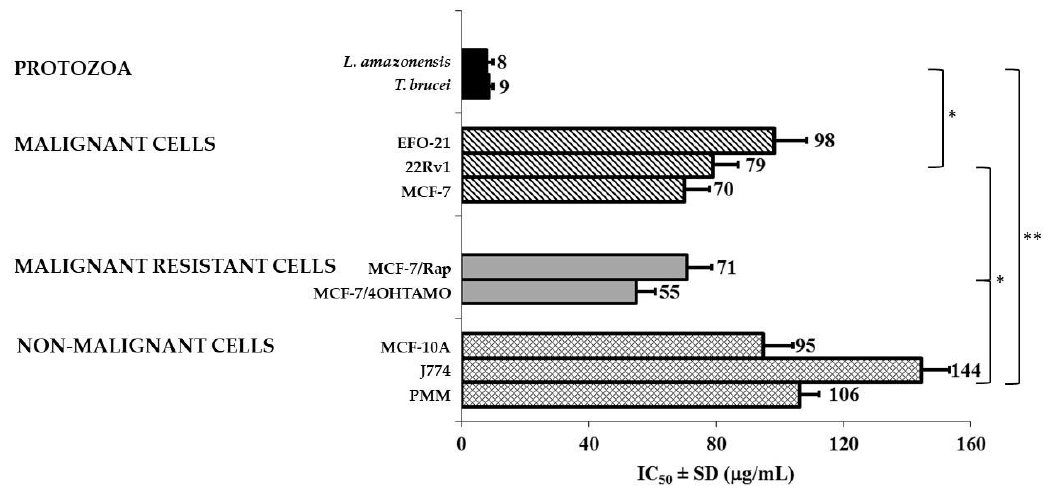
Figure 2. In vitro antitrypanosomatidae, antiproliferative activity, and cytotoxic effects of essential oil extracted by hydrodistillation from Melaleuca leucadendra collected in National Botanic Garden, Havana, Cuba. Statistical differences with p < 0.05 (*) and p < 0.01 (**) compared to control cells.